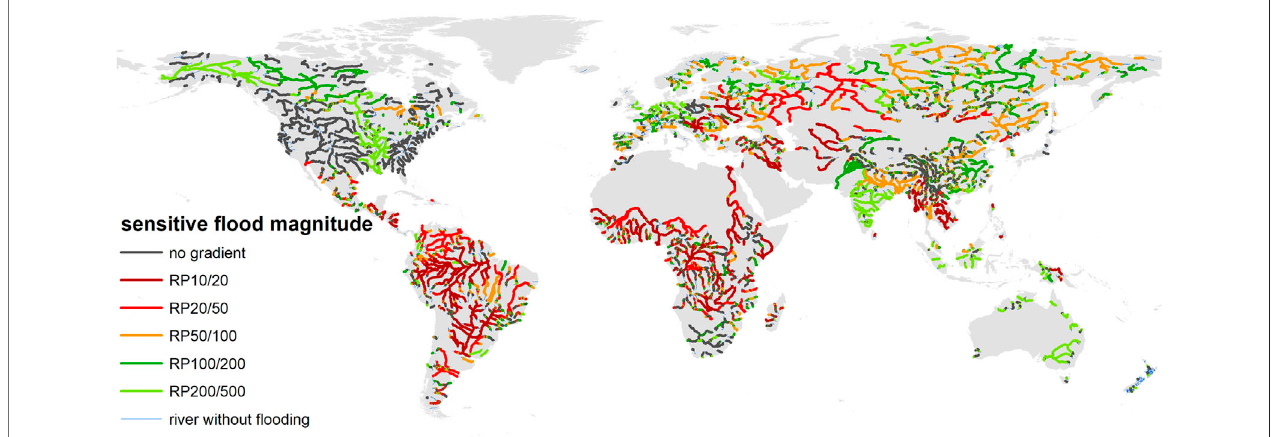
FIGURE 8 | Range of fl ood magnitudes showing the highest relative gradient for sensitivity to